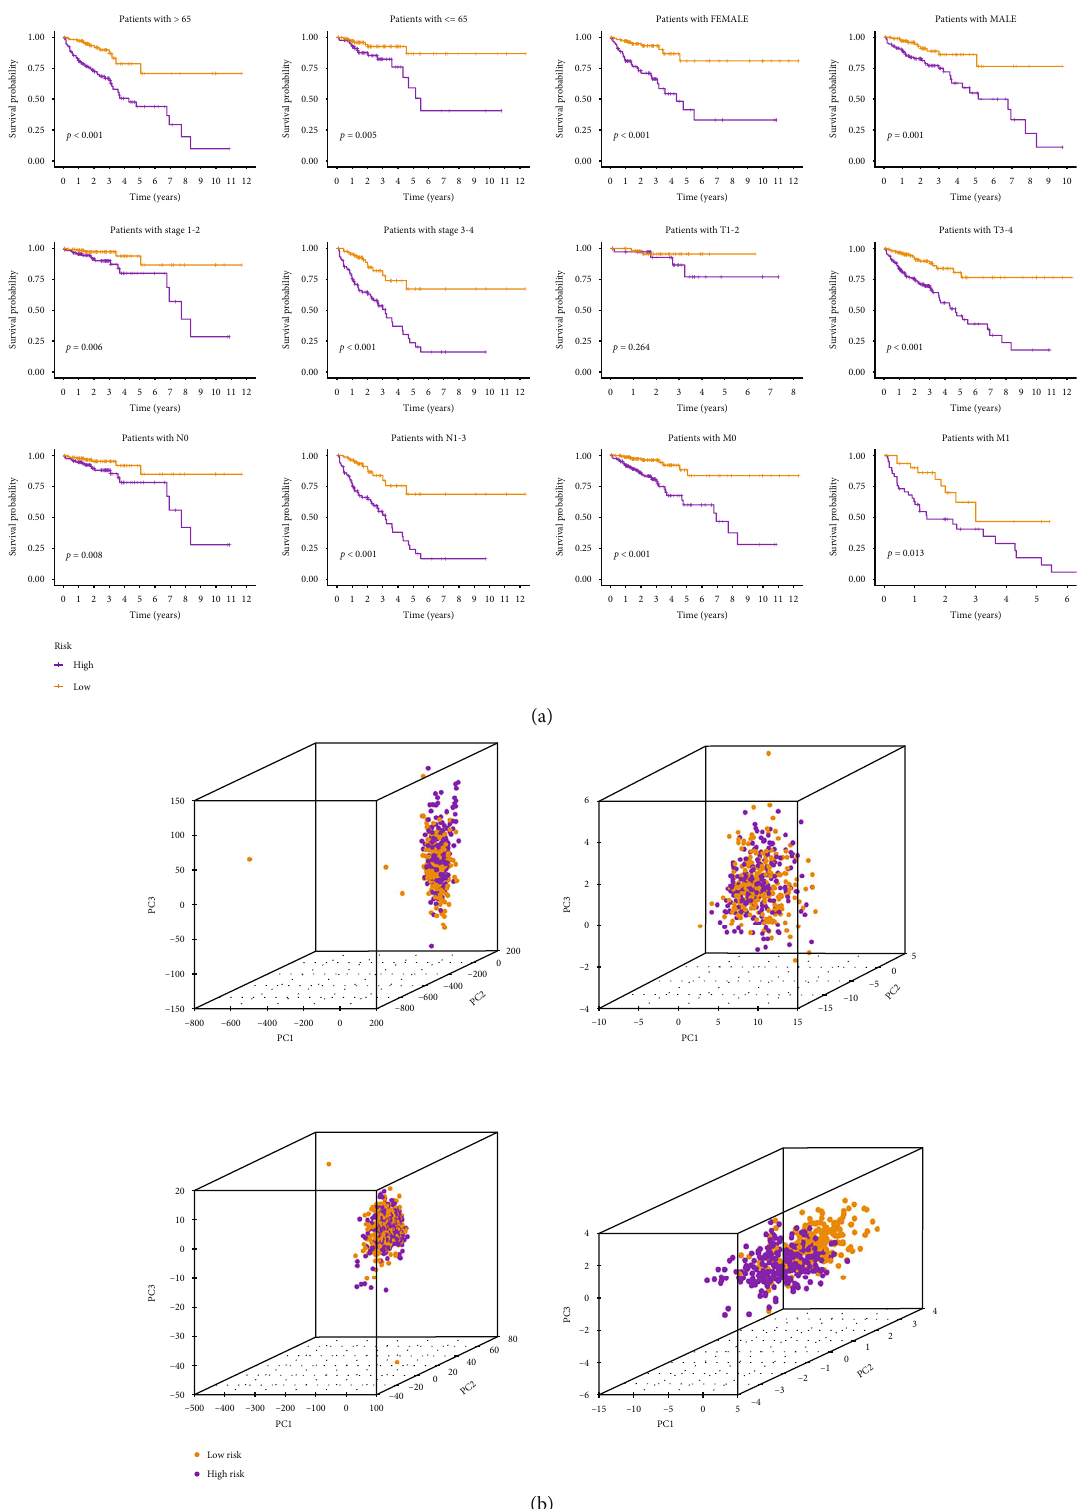
Figure 3: Validation of a risk signature. (a) Kaplan-Meier curves grouped by age, gender, clinical stage, T, N, or M. (b) PCA comparison on the basis of entire gene pro fi les, m 5 C genes, lncRNAs, and m 5 CRlncRNAs in TCGA entire